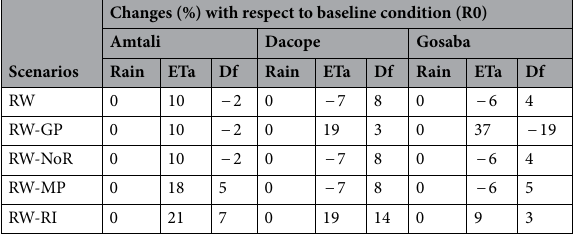
Table 4. Changes (%) in rainfall (Rain), actual evapotranspiration (ETa), and surface runoff (Df) under different management scenarios.